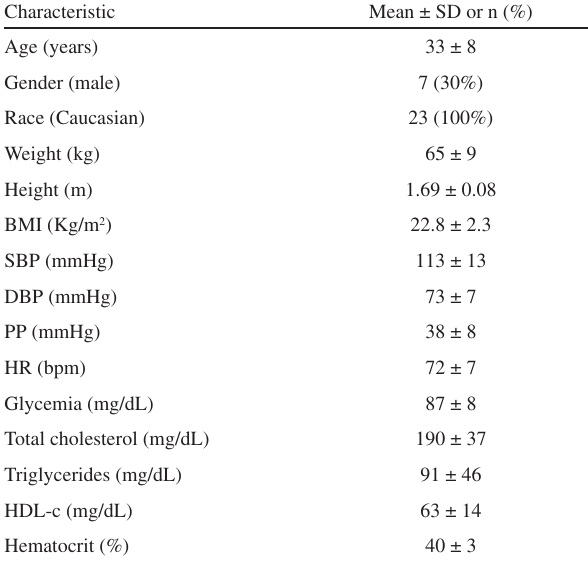
Table 1 - Characteristics of the studied subjects Characteristic